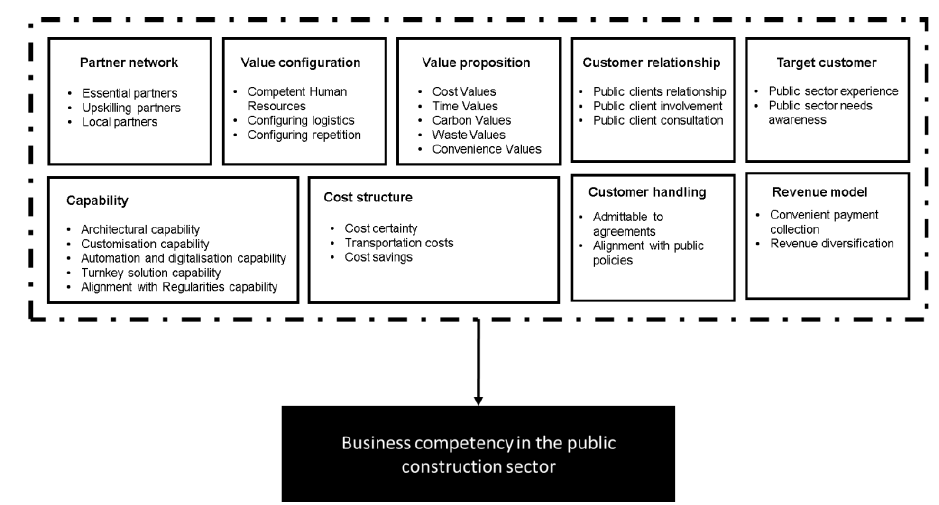
Figure 6. Business model elements influencing demand.